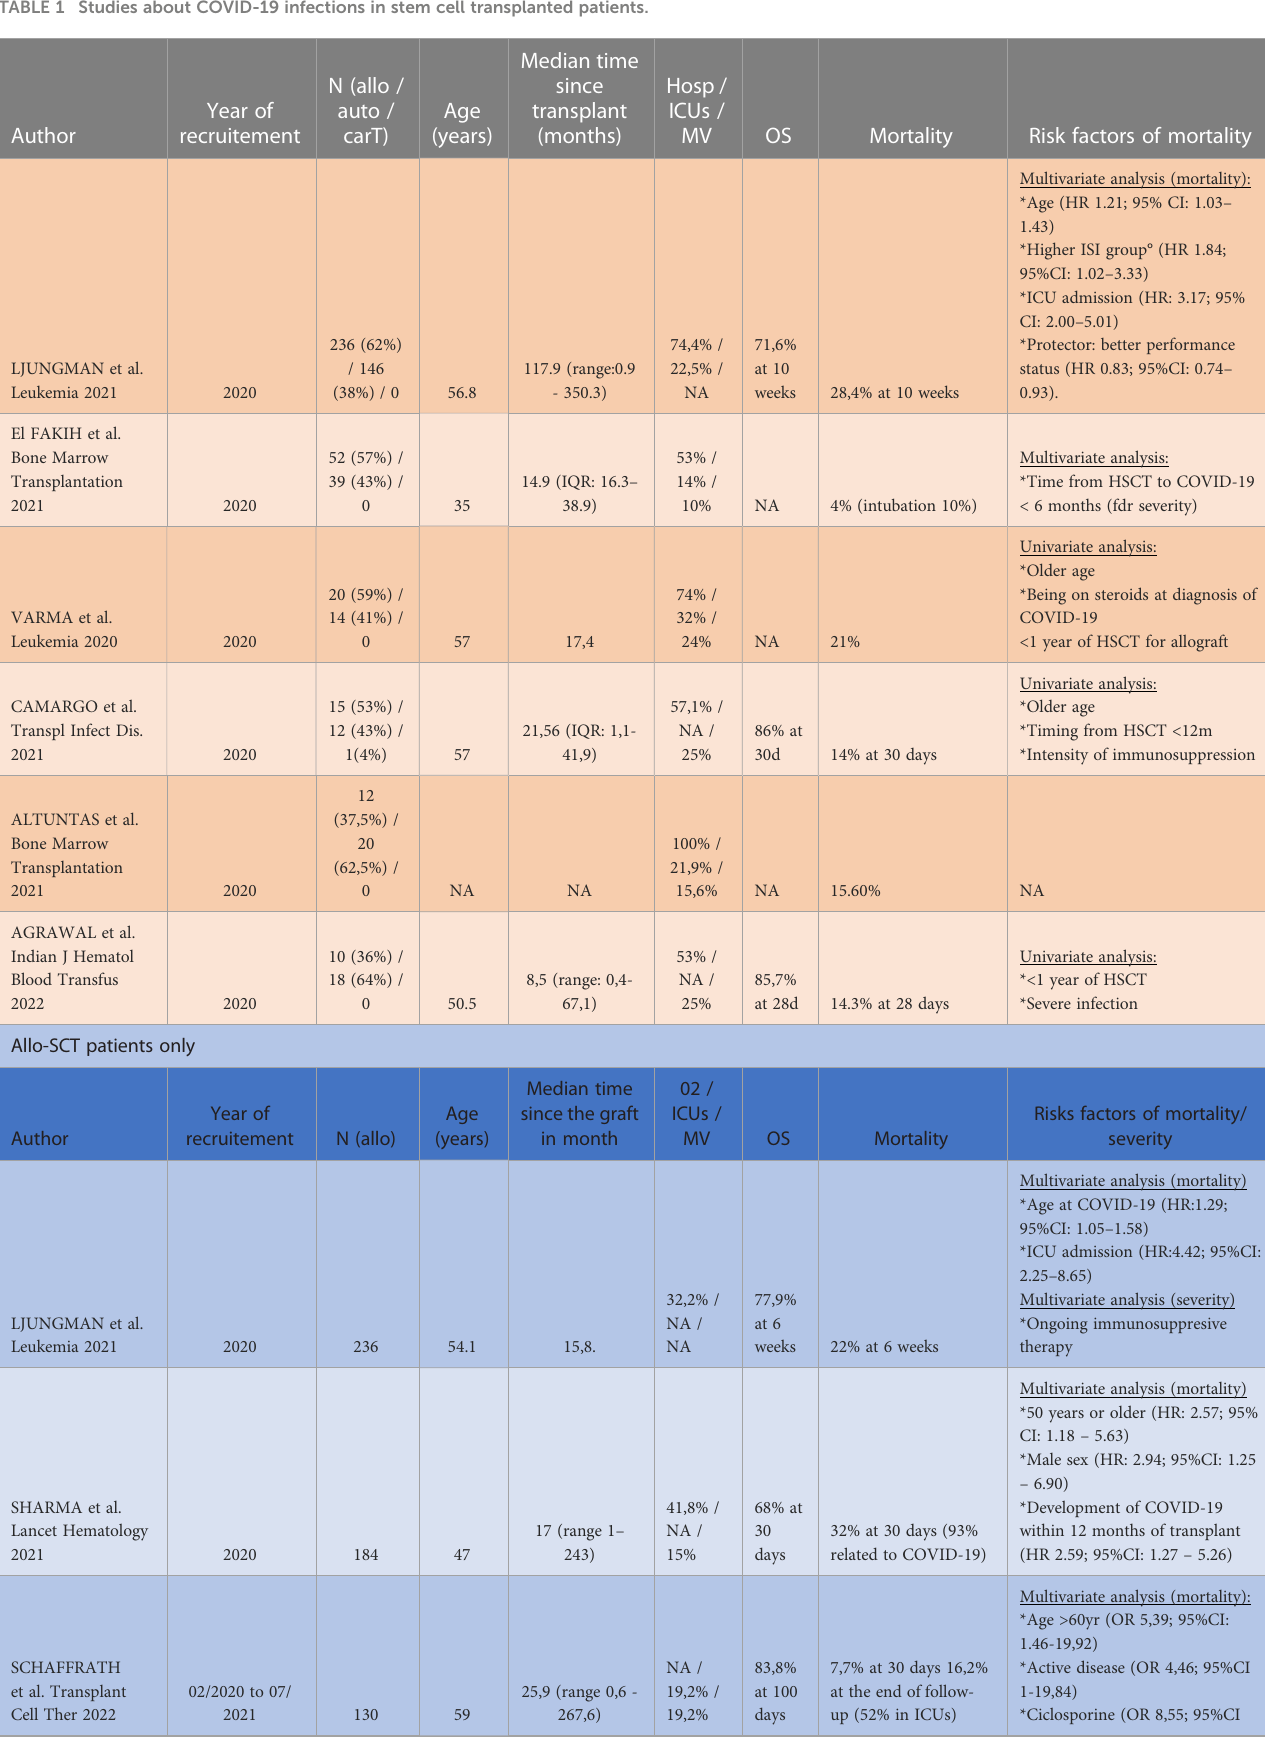
TABLE 1 Studies about COVID-19 infections in stem cell transplanted